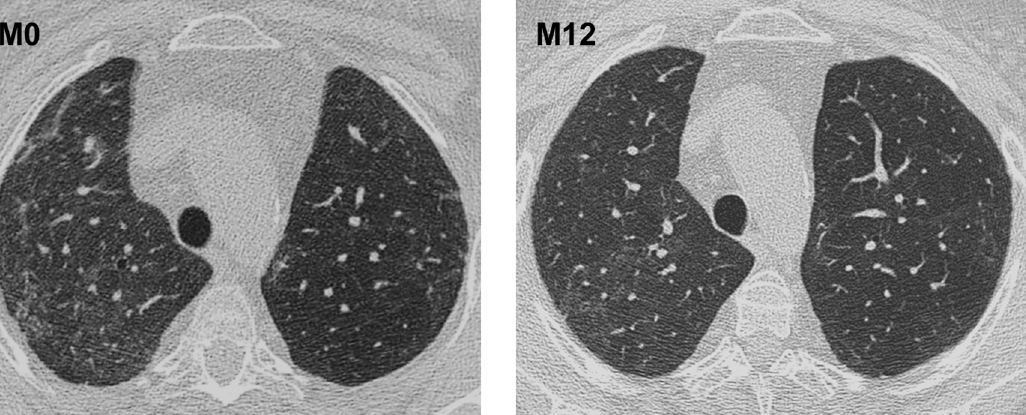
Fig 3. Interstitial lung disease evolution. Lung CT scans, before enrolment (M0) and 1 year later (M12), of the only patient with and nonspecific interstitial pneumonia improving after rituximab